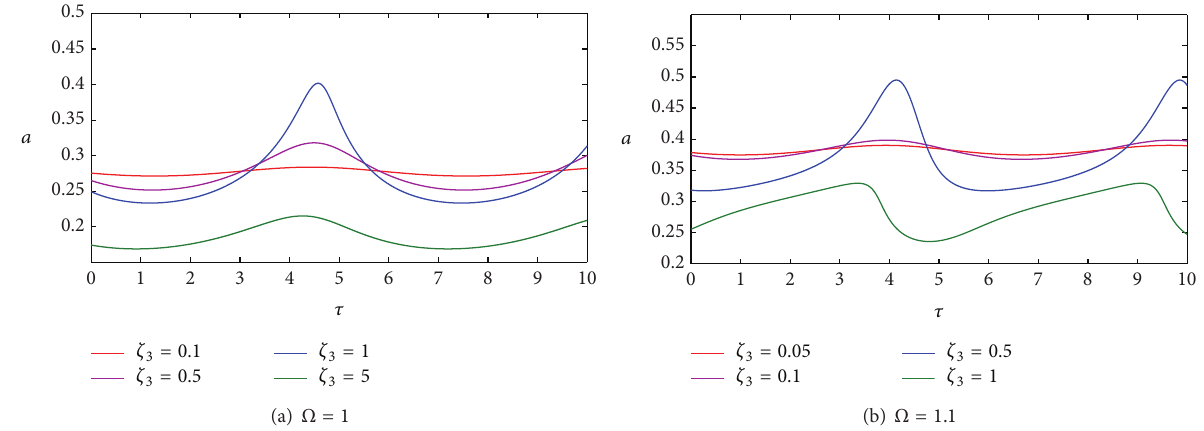
Figure 5: Effect of the time delay 𝜏 on the primary resonance for the controlled system with different feedback gain 𝜁 3 ( 𝜁 1 = 0.025 , 𝑓 1 = 0.05 , 𝑘 = 1 , and ̂𝜆 = 0.4 ).